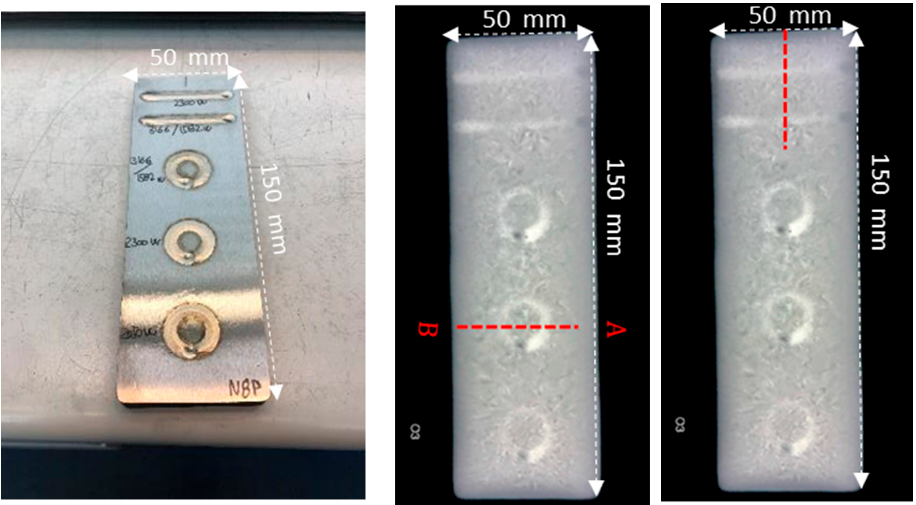
Figure 8. Bead-on-plate trials and X-ray digital images showing cuts for cross-section metallographic examination.